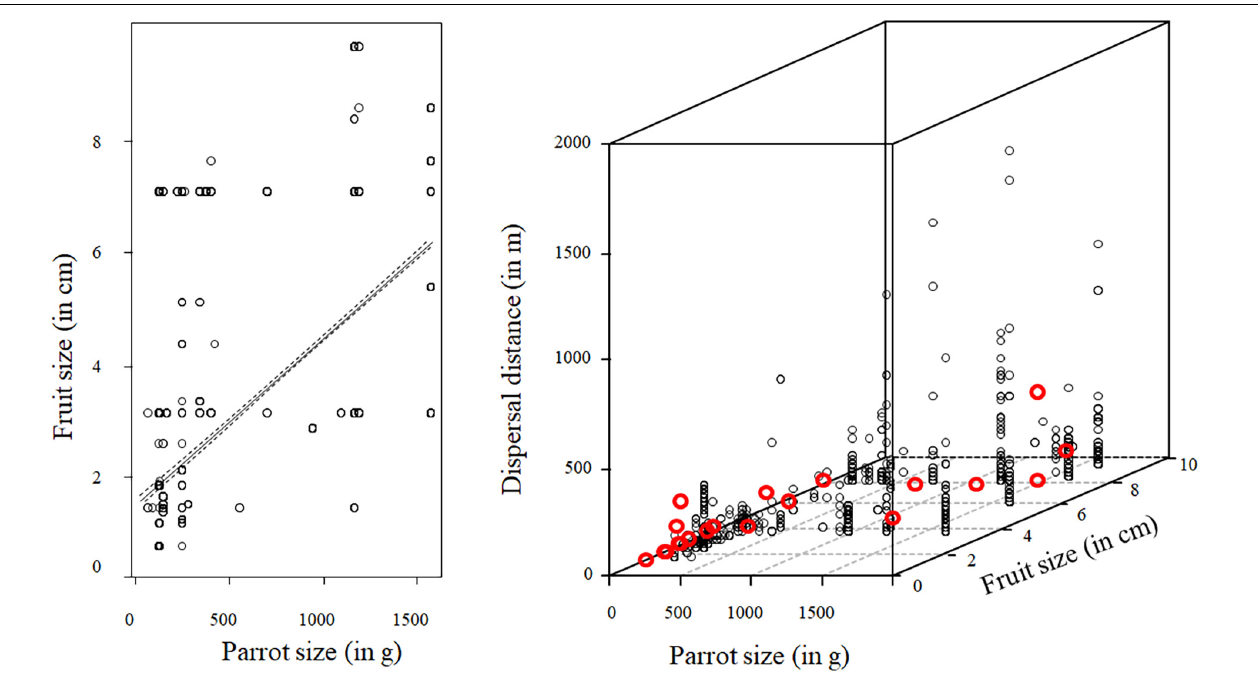
FIGURE 6 | Relationship between the size of palm fruits (in cm) dispersed by parrots and their size (in g), and how these variables affect observed dispersal distances. Red points show the relationship among the mean dispersal distances estimated for each palm species considering the right-censored nature of data (through Kaplan Meier Survival Curves), the size of the palm fruits, and the mean size of parrots moving them (for details, see Table 3